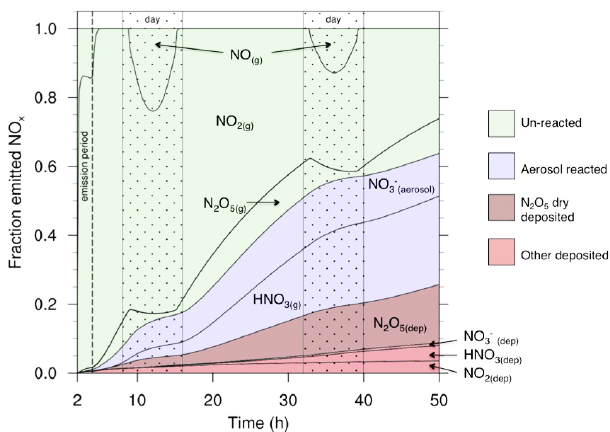
Figure 5. Speciation diagram of reactive nitrogen species showing column-integrated concentrations plus time integrated depositional loss as a function of time. Color categories correspond to Fig.